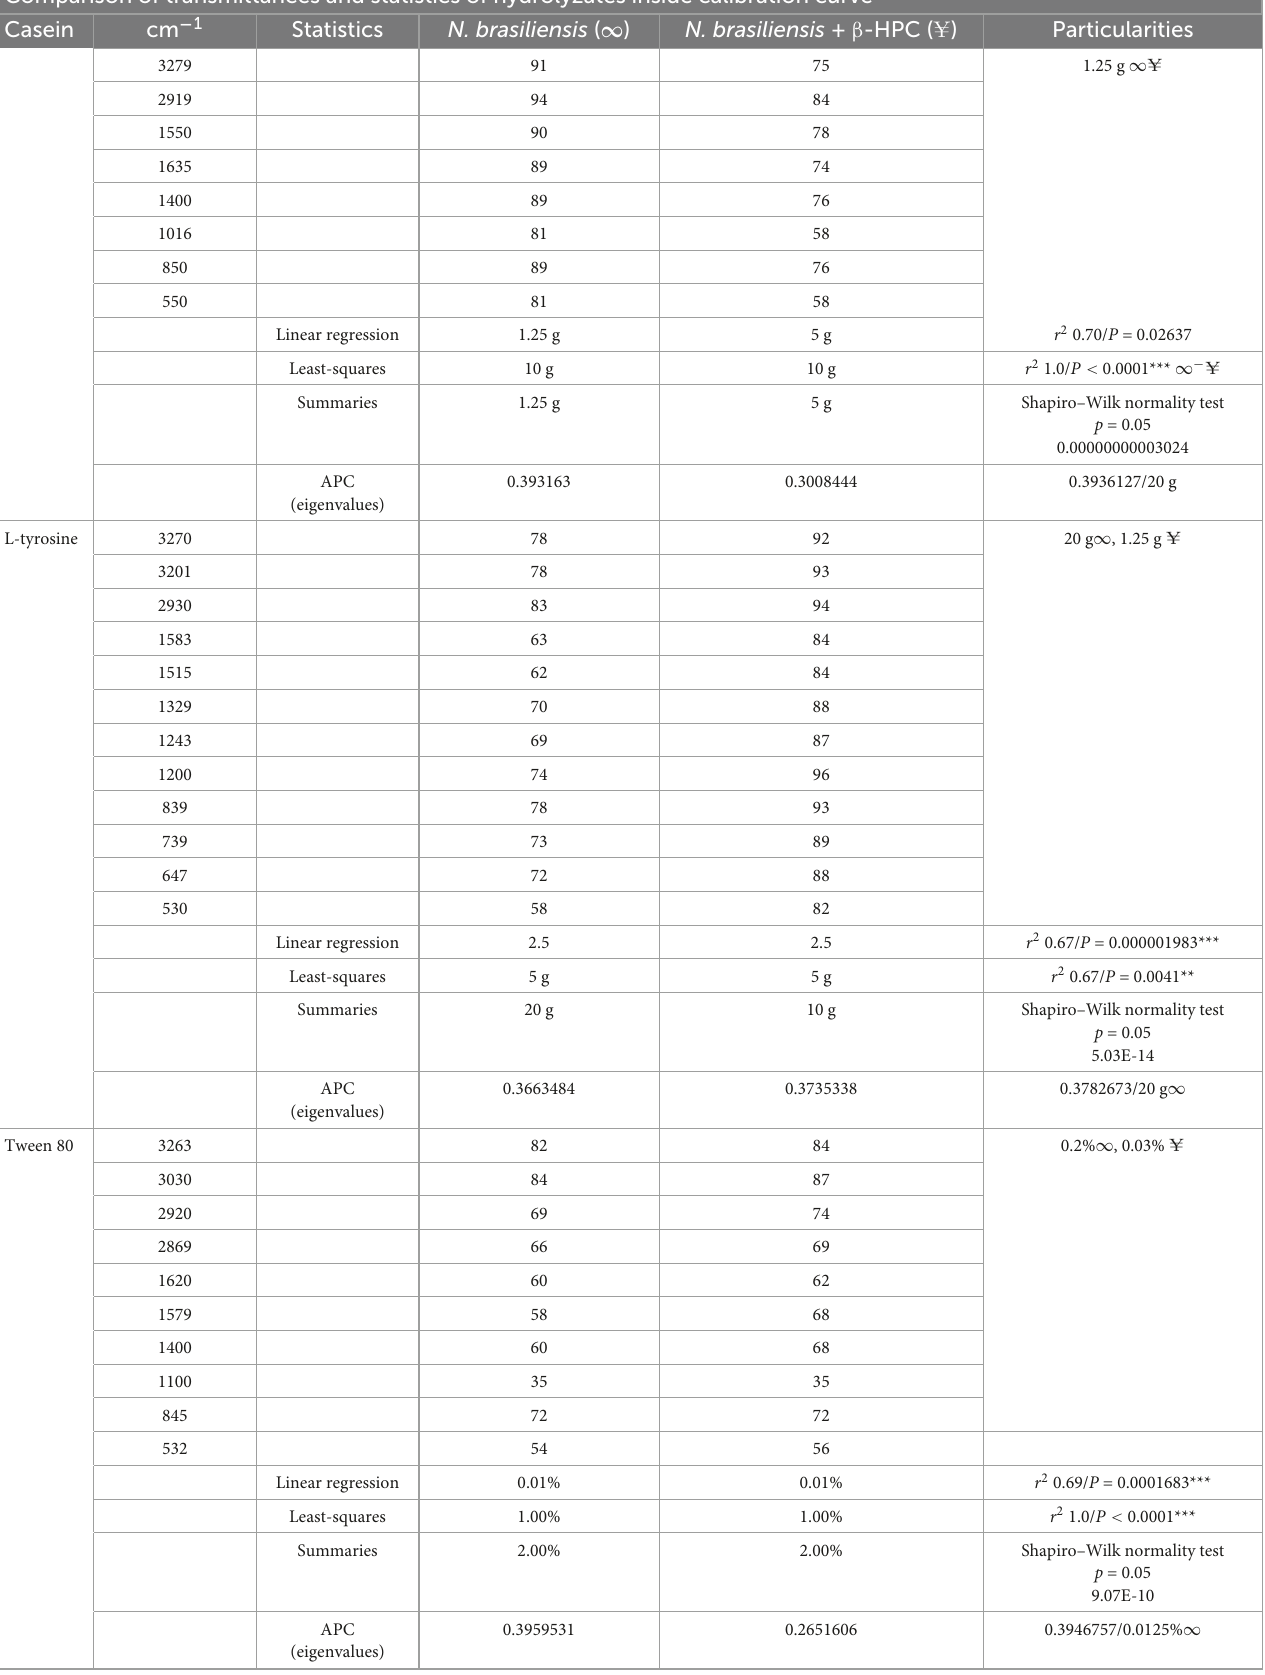
TABLE 2 Comparisons of hydrolyzates resulting from catabolism between N. brasiliensis and N. brasiliensis + β -HPC and within a calibration curve from casein, L-tyrosine, Tween 80, and egg yolk. Comparison of transmittances and statistics of hydrolyzates inside calibration curve